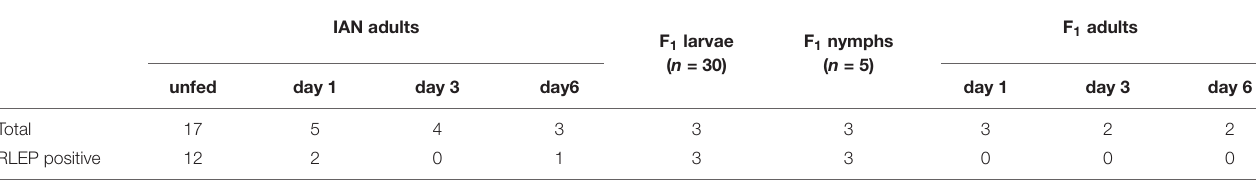
TABLE 2 | Tick samples assessed for M. leprae infection upon exposure by needle inoculation. IAN adults